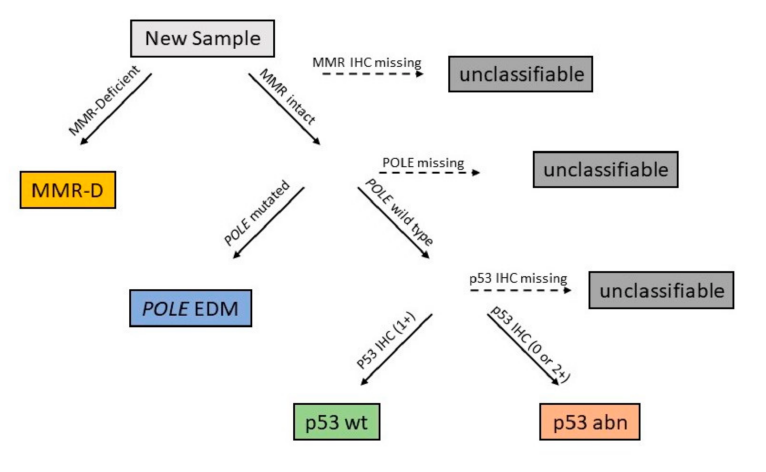
Figure 1. The Proactive Molecular Risk Classifier for Endometrial Cancer (ProMisE) Algorithm to assess a new endometrial cancer sample. First, mismatch-repair (MMR)-deficiency is evaluated with immunohistochemistry (IHC) against MSH 6 and PMS2 proteins. Second, the Polymerase Epsilon ( POLE) exonuclease domain is tested by sequencing exons 9–14. Lastly, IHC for p53 is performed to determine patients with normal expression (IHC score 1+) versus complete loss/null (IHC score 0) or accumulation (IHC score 2+). Reproduced with permission from